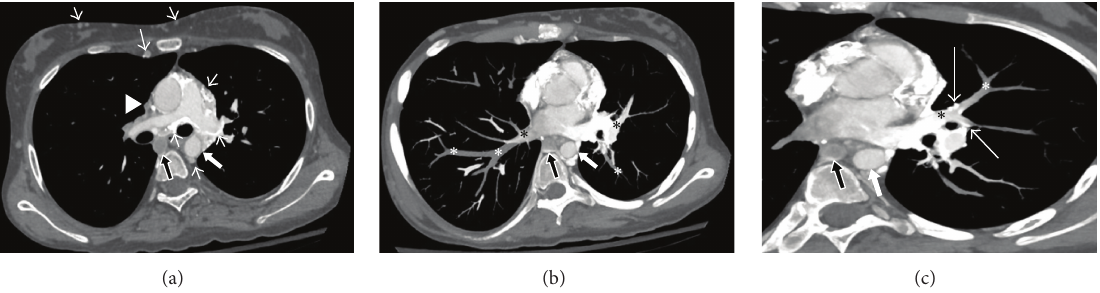
Figure 1: Enhanced axial chest CT image (a) and oblique axial thin-slab maximum-intensity-projection (MIP) images (b, c) inferior to (a) show thrombosed and stenosed SVC (arrowhead) and distended and occluded azygos vein (black block arrow). There are chest wall, accessory hemiazygos, and paravertebral, intense mediastinal venous collaterals (short arrows). Central superior pulmonary veins (black asterisks) are opacified through adjacent collateral (long white arrows) as compared to nonopacified peripheral portions (white asterisks). Note the contrast filled aorta (white block arrow).